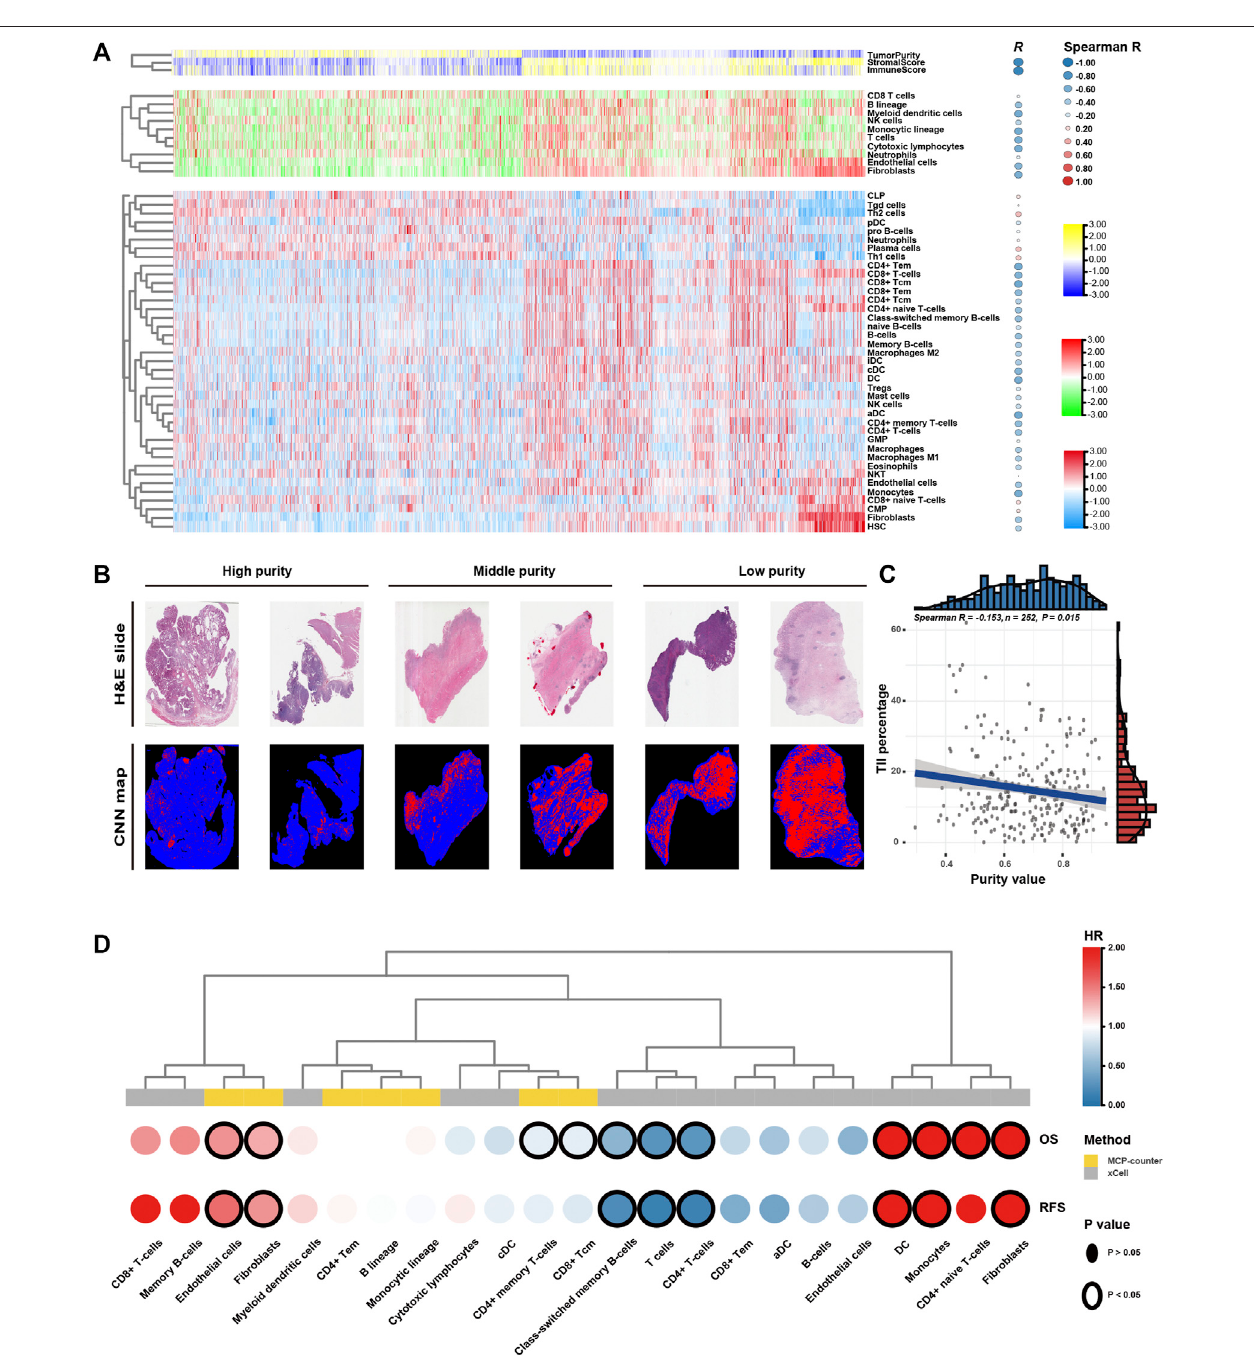
FIGURE 5 | Tumour microenvironment features of tumour purity in gastric cancer (GC). (A) Heatmap of the in fi ltration level of stromal and immune cells among the purity-based subtypes. (B) Representative slides (top) and tumour-in fi ltrating lymphocyte (TIL) maps (bottom) of GC tissues with different purity values. The red colour represents a positive TIL patch, the blue colour represents a tissue region with no TIL patch and the black colour represents no tissue. (C) The Spearman correlation between TILs and purity value. (D) Heatmap of survival analysis of purity-related stromal and immune cells for overall survival (OS) and recurrence-free survival (RFS). CNN, convolutional neural network; H&E, haematoxylin and eosin; OS, overall survival; RFS, recurrence-free survival; HR, hazard ratio.